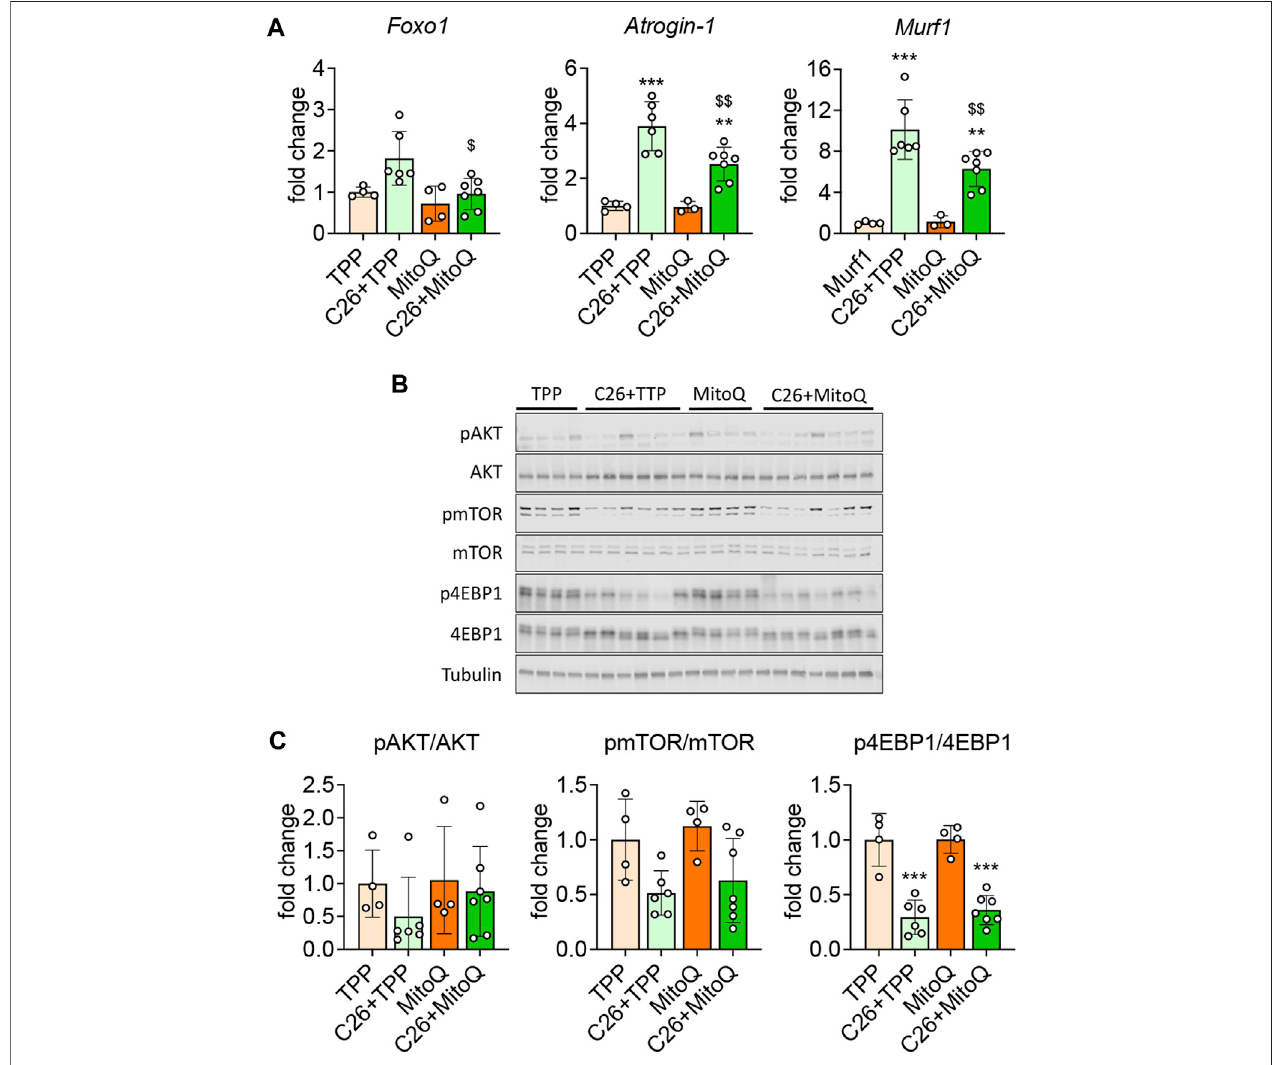
FIGURE 3 | MitoQ treatment partially normalizes protein catabolism and anabolism. (A) Gene expression levels for Foxo1 , Atrogin-1 and Murf1 in the gastrocnemius muscle. (B,C) Representative Western blotting and quanti fi cation for phospho-AKT (pAKT), AKT, phospho-mTOR (pmTOR), mTOR, phospho-4EBP1 (p4EBP1), 4EBP1. Protein expression was represented as a ratio of phosphorylated protein/total protein. Tubulin was used as loading control. Data were expressed as fold change vs. TPP. Statistical signi fi cance was evaluated by two-way analysis of variance, and signi fi cant differences (at least p < 0.05) were reported as ** p < 0.01, *** p < 0.001 vs. TPP; $ p < 0.05, $$ p < 0.01 vs. C26 +